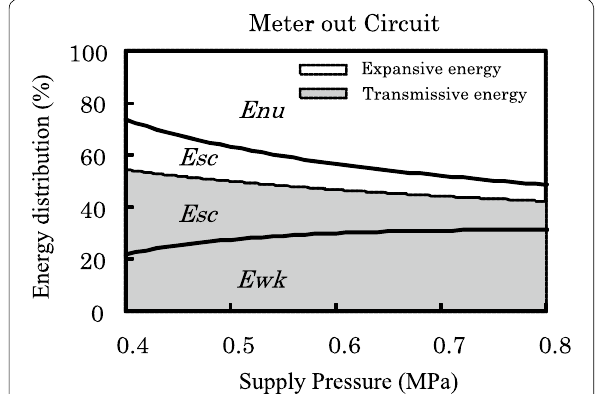
Figure 8 Energy distribution driven by an ideal meter-out